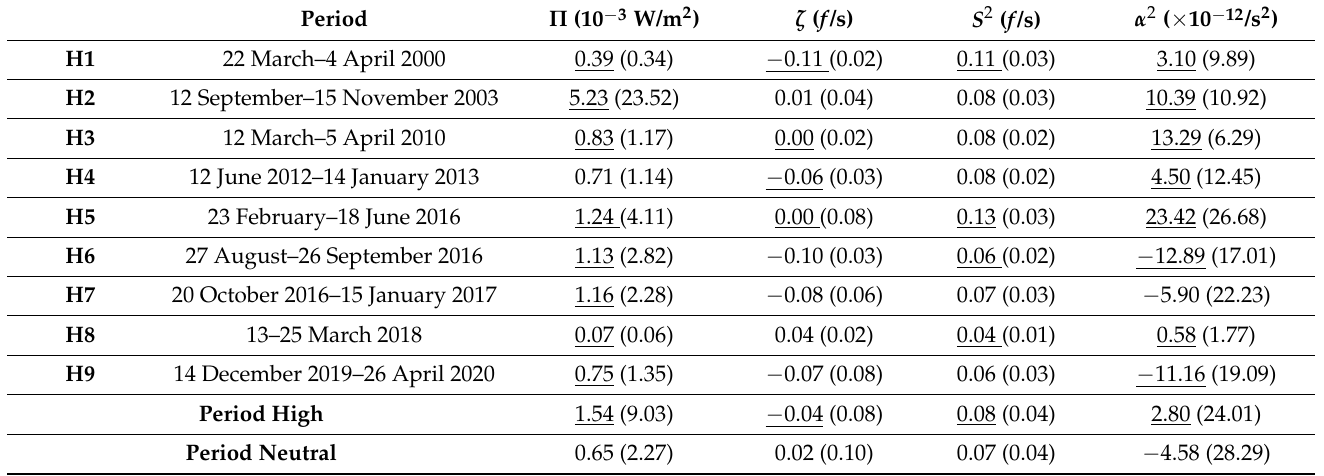
Table 2. Same as Table 1 but during period low.